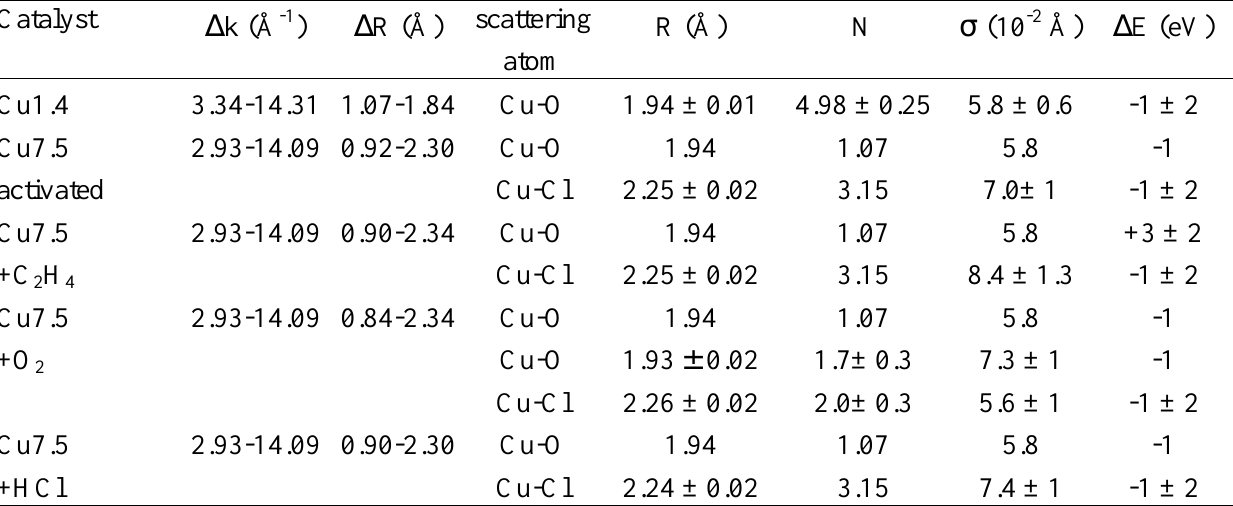
Table 2. Filtering ranges and EXAFS results for first coordination sphere of the g -Al CuCl catalysts: D k (interval of k-space to R-space FT); D R (R-space interval selected to perform the 2 first shell-filtered Back FT into k-space); R (bond distance); N (coordination number); s (relative